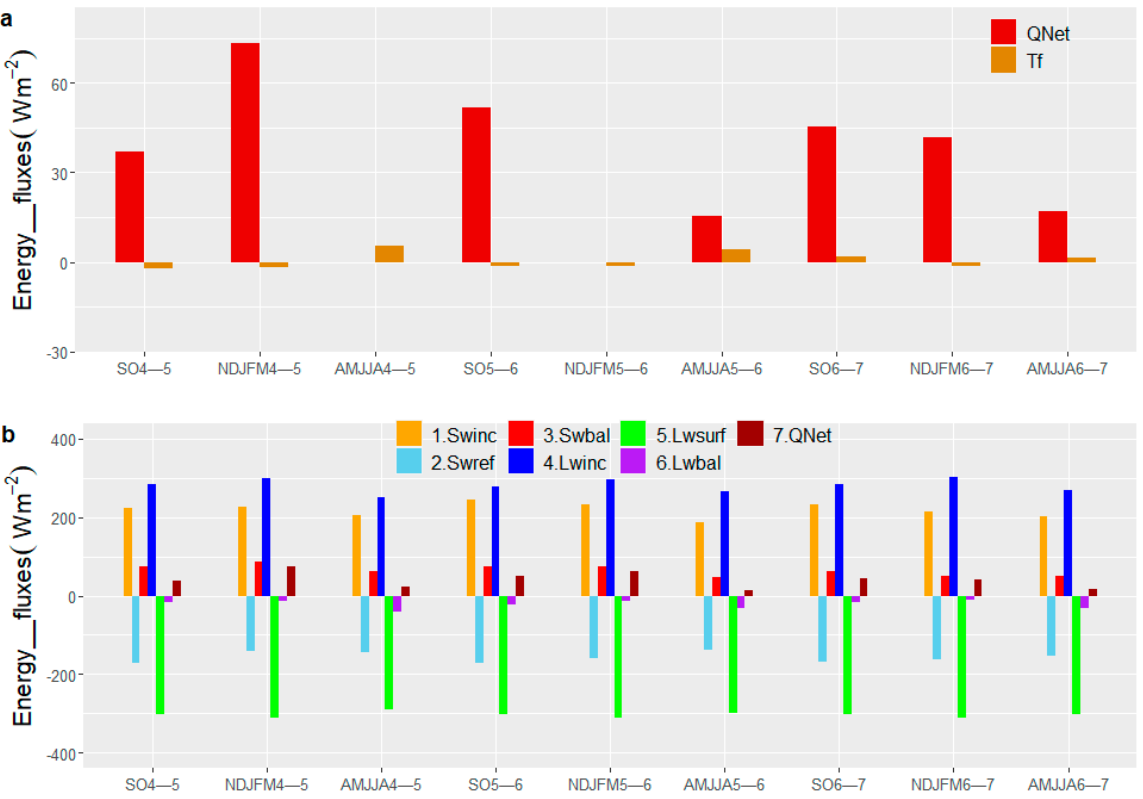
Figure 8. ( a ) Simulated mean seasonal net radiation and turbulent fluxes on the Artesonraju glacier; ( b ) simulated mean seasonal contributions of the various radiative flux terms.